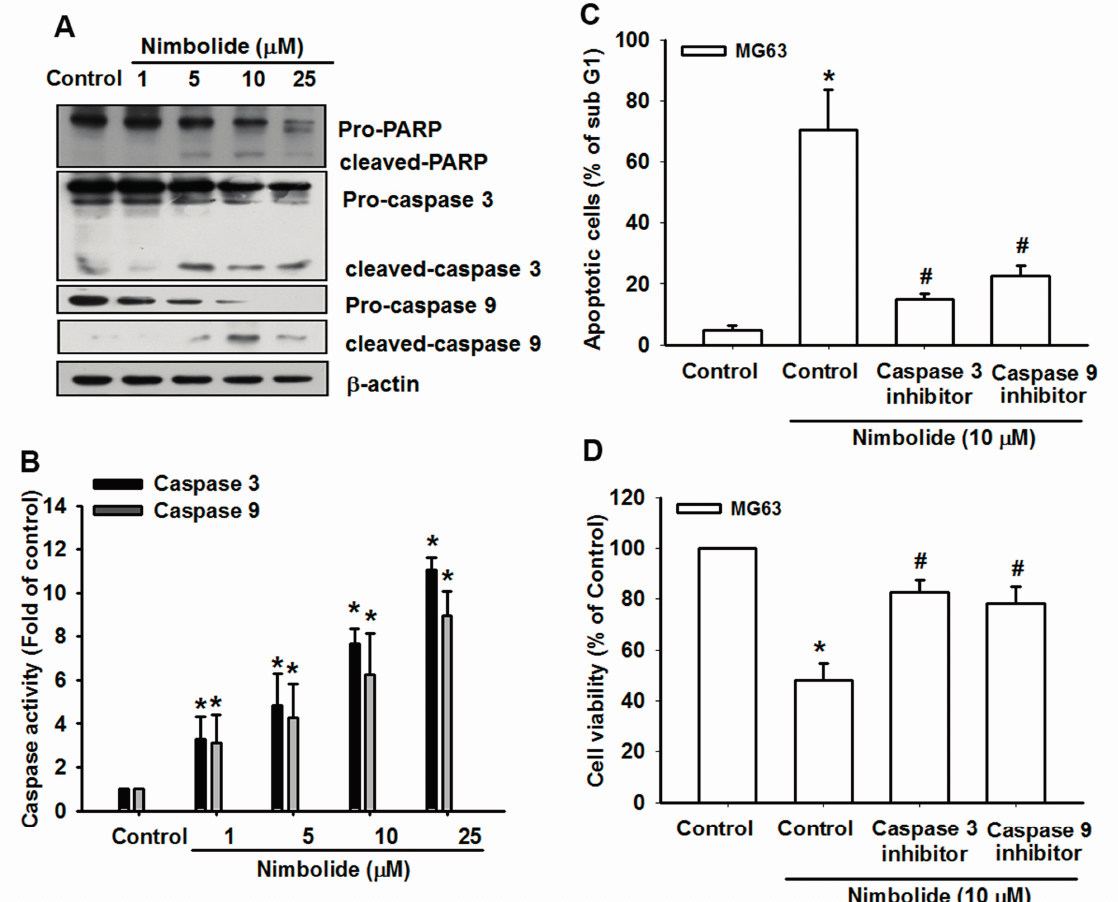
Figure 4. Nimbolide induces the activation of caspases in human osteosarcoma cells. ( A ) MG63 cells were treated with control solution or various concentrations of Nimbolide for 24 h. The expression levels of PARP, caspase-3, and caspase-9 were examined by using western blot analysis; ( B ) MG63 cells were treated as described in ( A ). The activities of caspase-3 and caspase-9 were examined by using a caspase ELISA kit; ( C , D ) MG63 cells were pretreated for 30 min with inhibitors of caspase-3 and caspase-9, followed by treatment with Nimbolide (10 μ M) for 24 h. The percentages of apoptotic cells were then analyzed by flow cytometric analysis of PI-stained cells ( C ). Cell viability was examined by using an MTT assay ( D ). The data are expressed as the mean ± SEM. * p < 0.05 compared with controls. # p < 0.05 compared with the Nimbolide treated